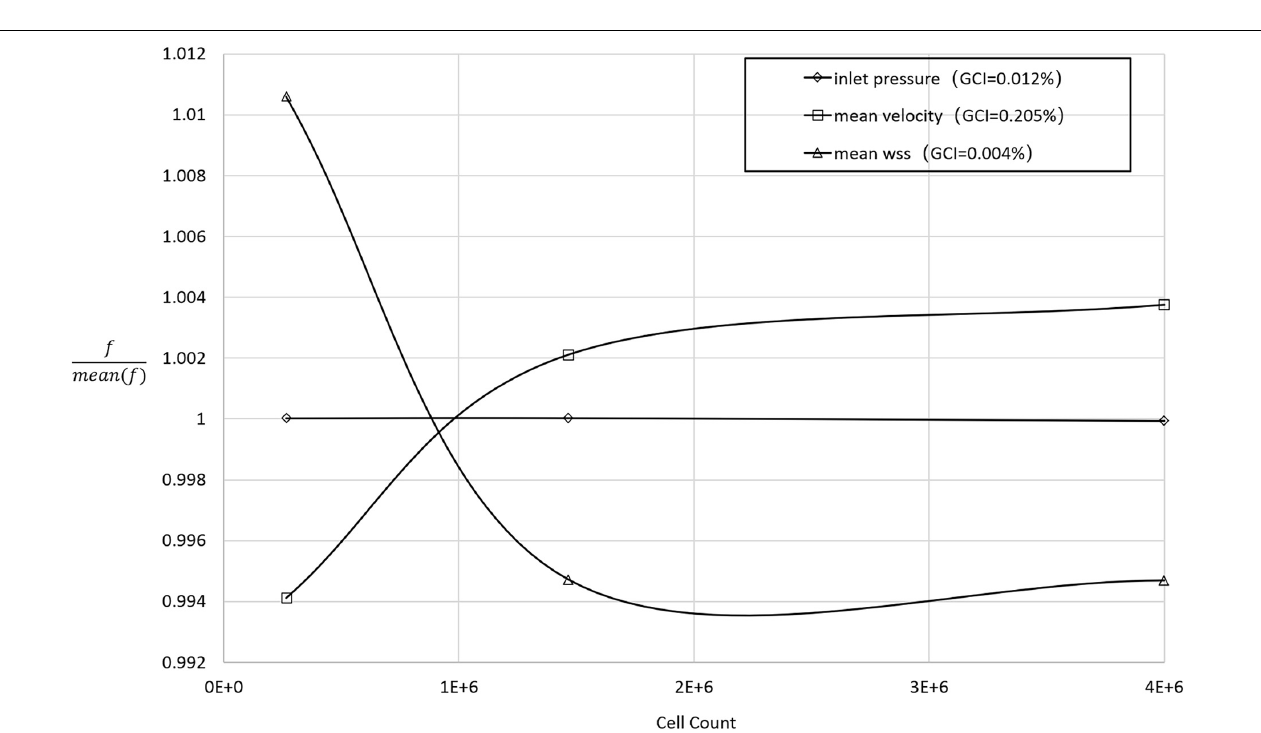
FIGURE 2 | The normalized grid convergence of mean WSS, mean velocity, and inlet pressure plotted against the number of mesh cells in the model domain. The results of the GCI calculations are included in the legend.